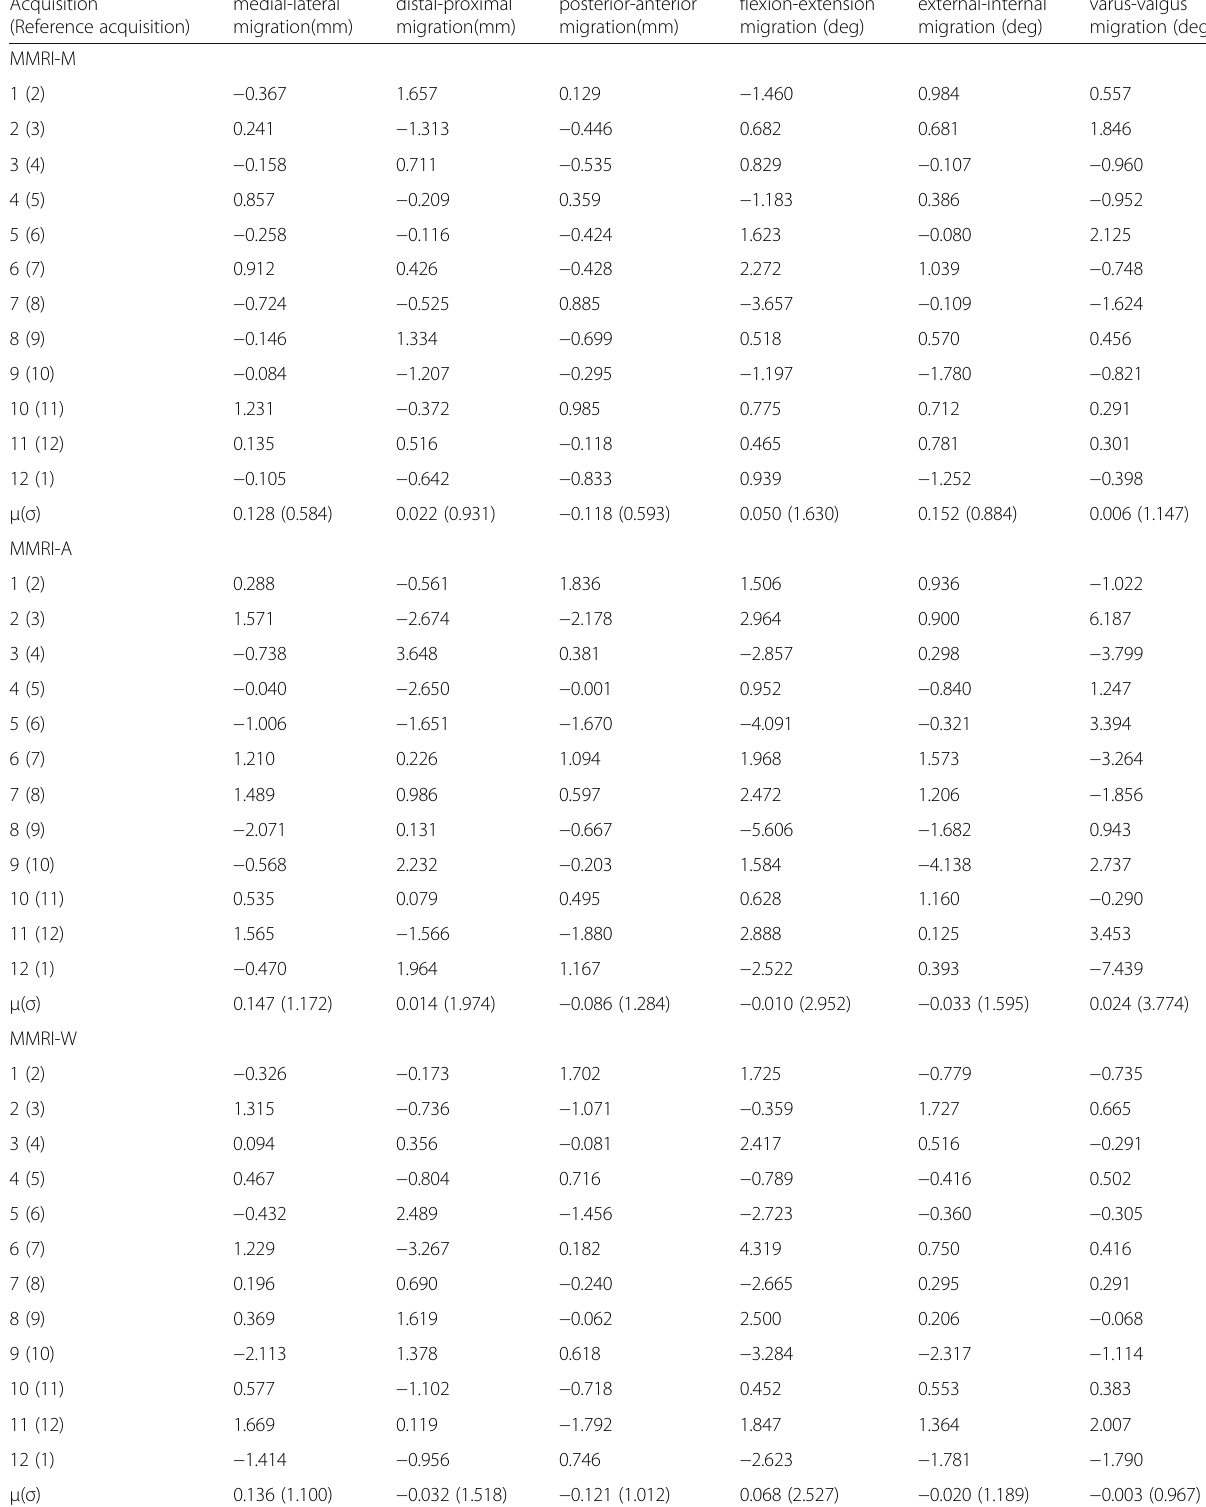
Table 1 MRI images of the phantom of 12 different acquisitions have been registered with three different methods Acquisition (Reference